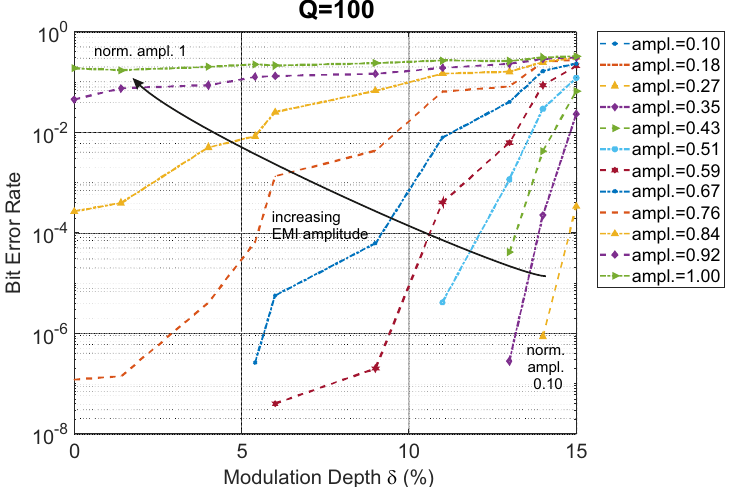
Figure 14. Bit error rate of a communication channel corrupted by SS-modulated EMI under strongly resonant coupling ( Q = 100) vs. different modulation depth δ at different EMI normalized r.m.s. amplitude